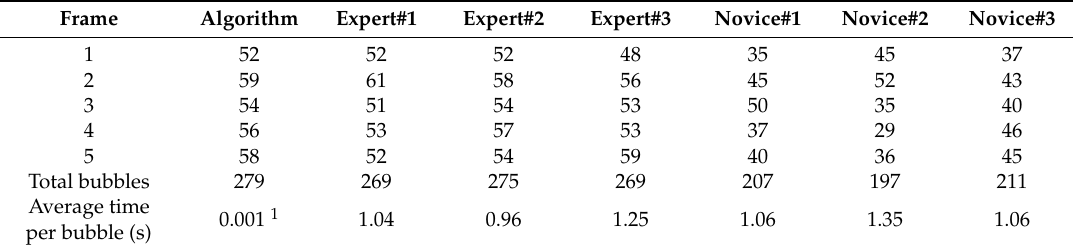
Table 2. Detected bubbles. Results for the two sets of human validators.